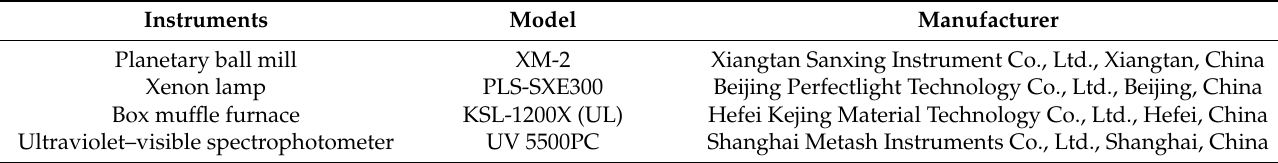
Table 7. Experimental instruments.